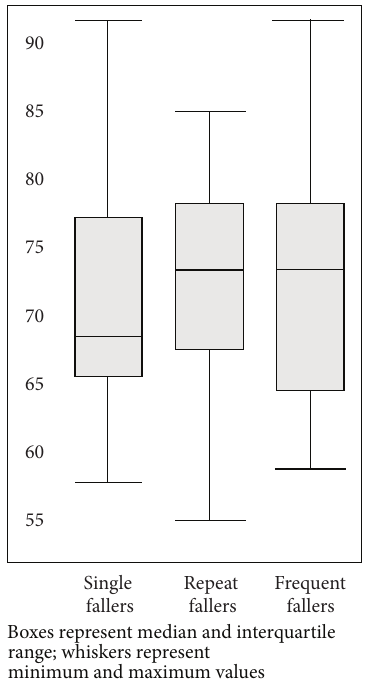
Boxes represent median and interquartile range; whiskers represent minimum and maximum values Figure 1: Box and Whisker Plot: Age (in years) by